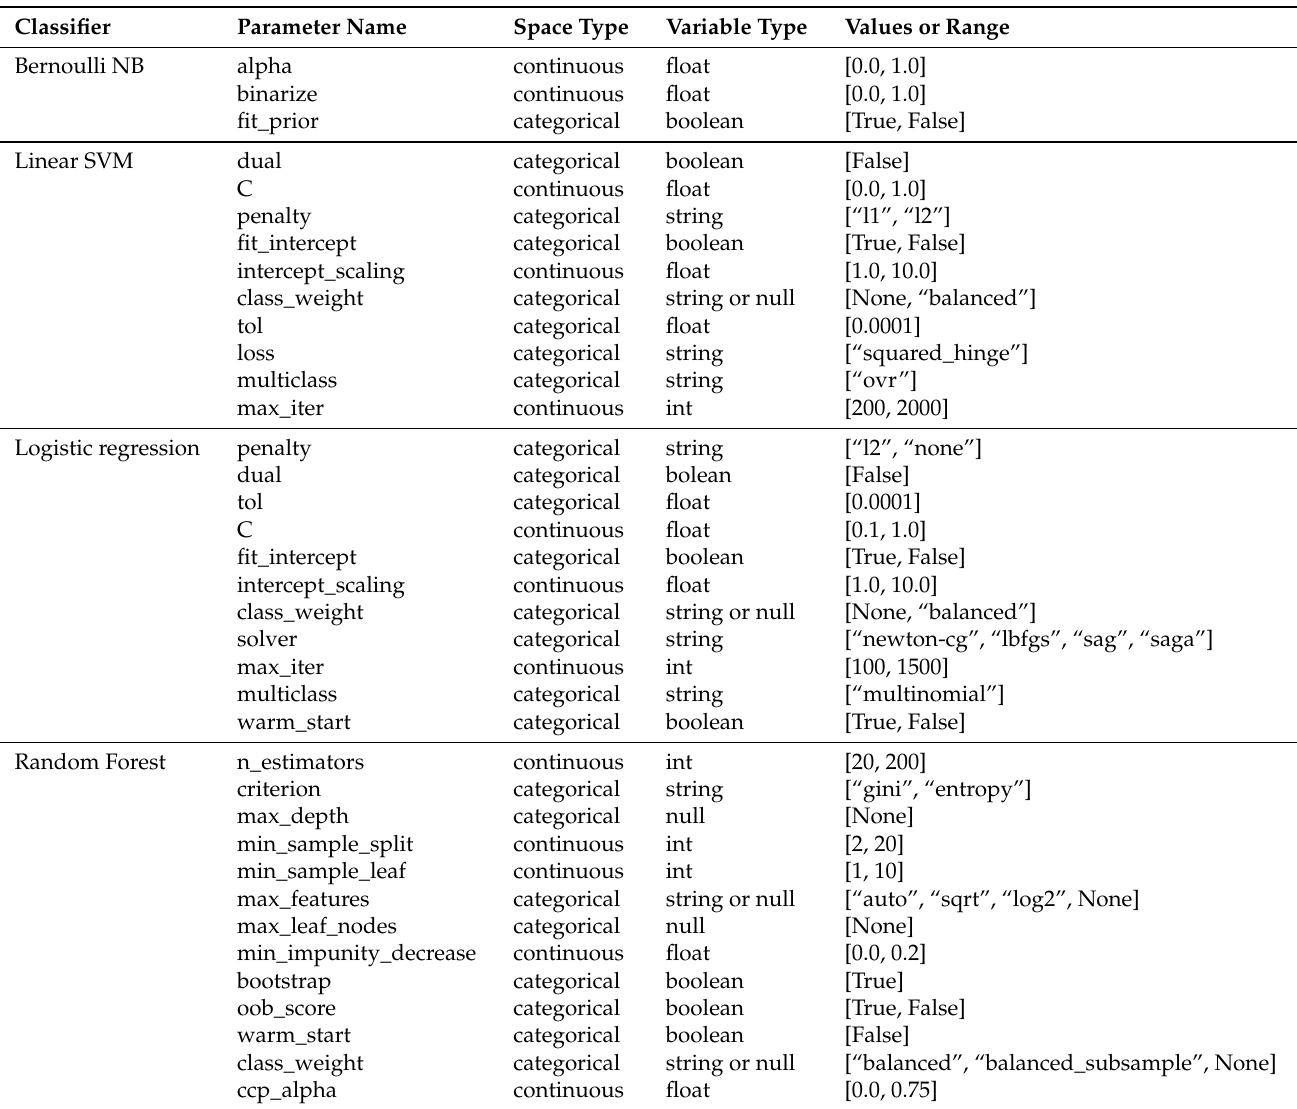
Table A1. Parameters and their values and ranges considered for EO hyperparameter search: classi- cal